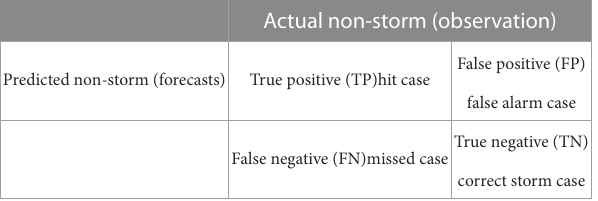
TABLE2 Confusionmatrixforthebinaryclassificationofnon-storm. TABLE3